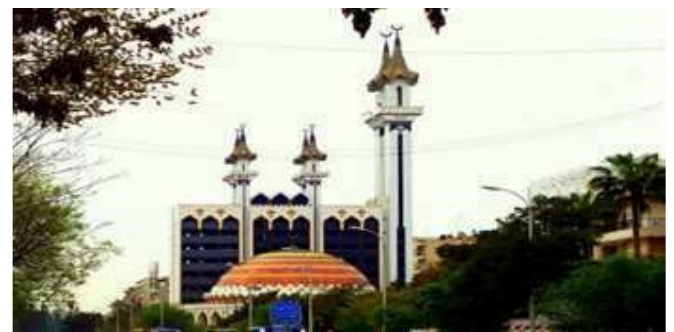
Fig. 4: Al-Rahman mosque, Aleppo, Syria (Kevorkmail, Fig. 4: Al‐Rahman mosque, Aleppo, Syria (Kevorkmail, 2010)